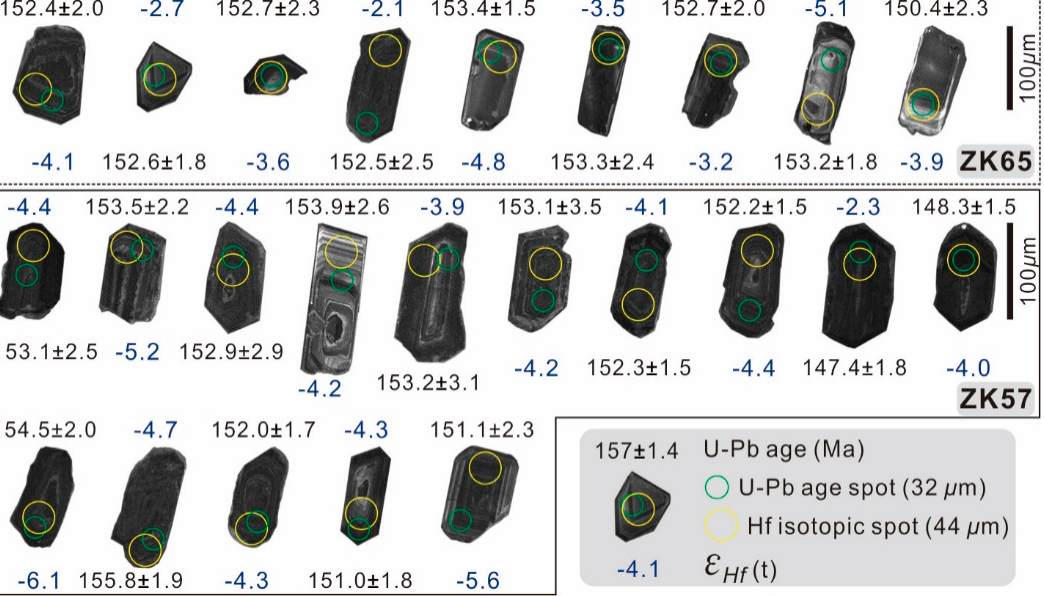
Figure 8. CL electron micrographs of representative zircons separated from the drill cores of ZK65 and ZK57 from the Xinfeng mine, Xianghualing area, South China. Spots are tested by in situ U – Pb age and Hf isotope.